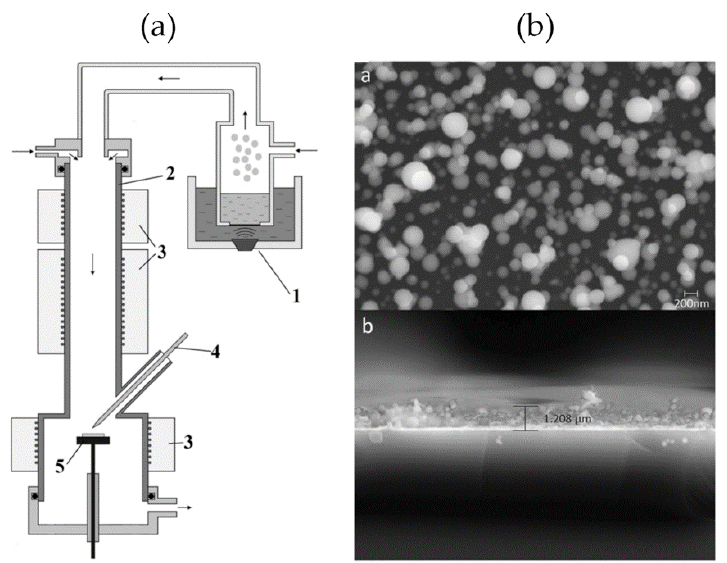
Figure 8. ( a ) Schematic diagram of the two-zone vertical reactor used in [91,135] for the AP deposition of inorganicNC coatings consisting of MoS 2 NPs embedded in a SiO 2 matrix (1, piezoelectric nebulizer; 2, quartz reactor; 3, heaters; 4, high-voltage corona electrode; 5, substrate plate). The MoS 2 NPs are synthesized in the upper zone by spray-pyrolysis, while the lower zone is used for co-depositing on the substrate surface the MoS 2 NPs and a SiO 2 layer formed by using a corona discharge fed with helium and TEOS. ( b ) Top-view and cross-sectional SEM images of the NC coatings. Reproduced with permission from [91].